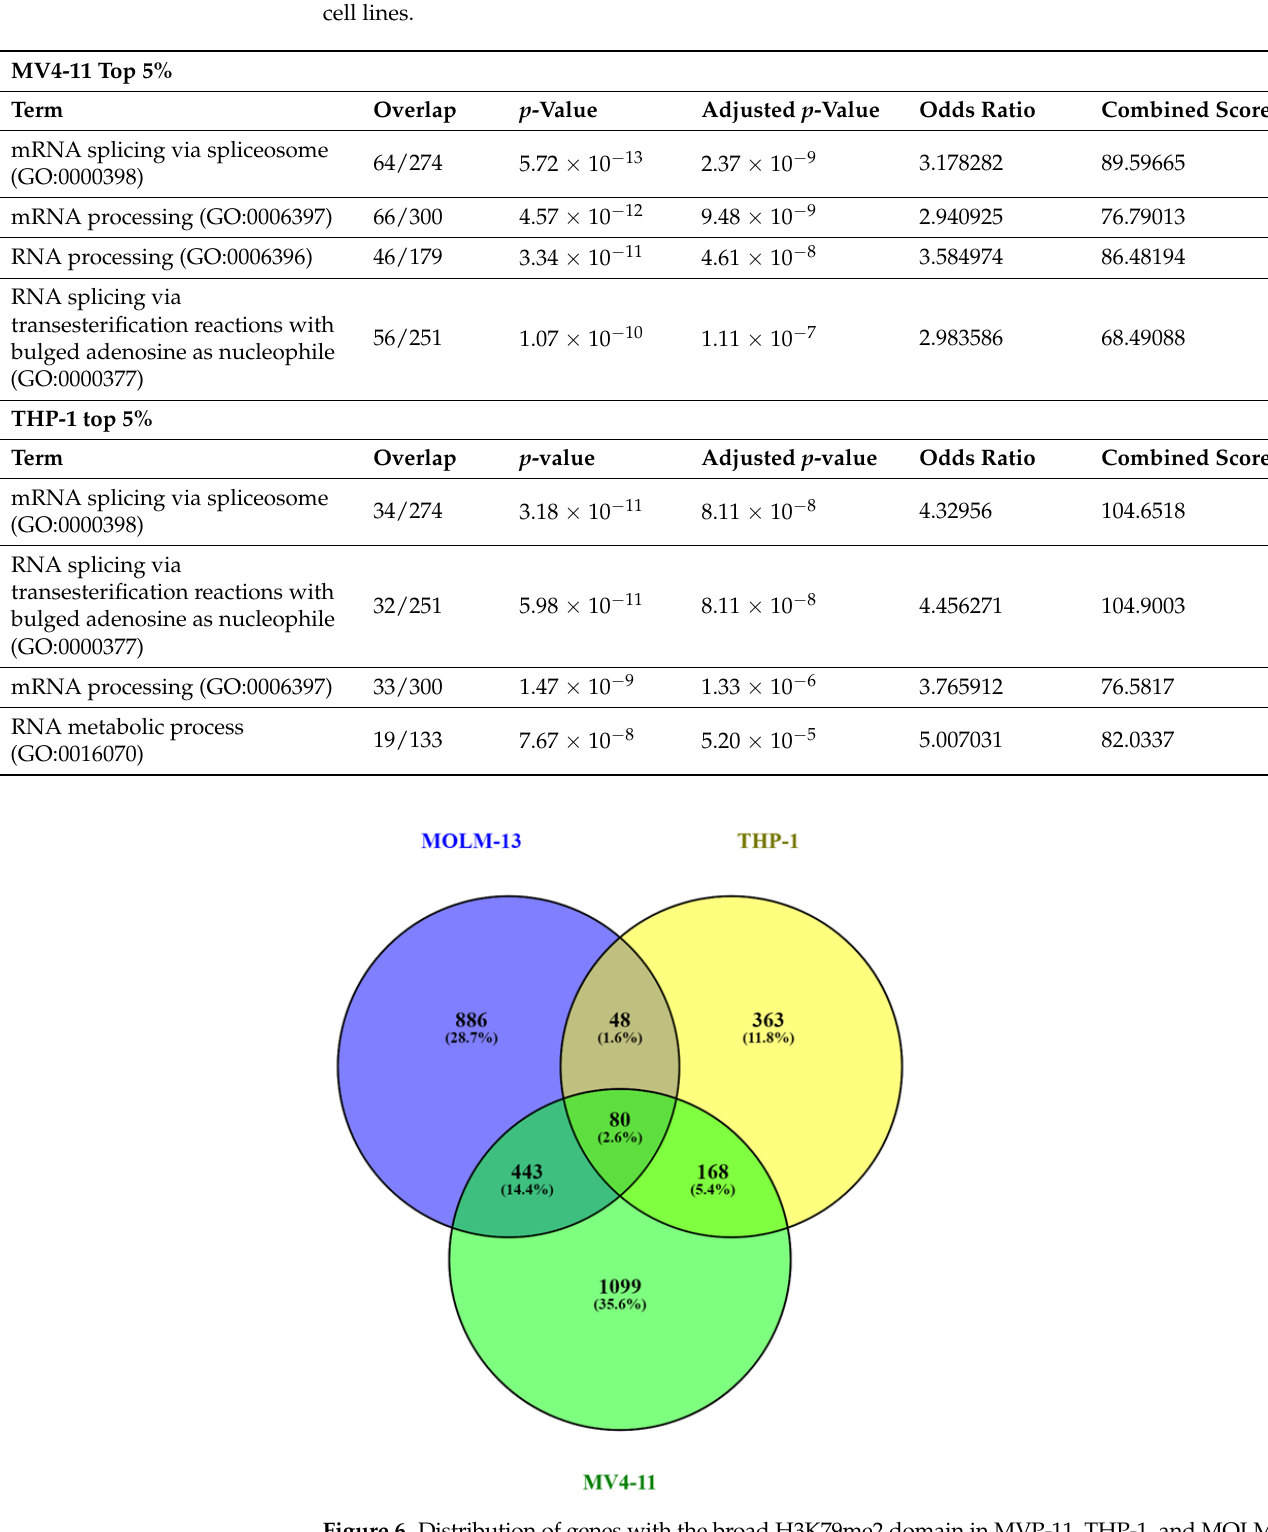
Figure 6. Distribution of genes with the broad H3K79me2 domain in MVP-11, THP-1, and MOLM-13. Genes unique and in common in the top 5% of genes with the broad H3K79me2 among the three AML cell lines. Table 4. GO terms (biological processes) for genes with broadest H3K79me2 domains unique to an AML cell line.